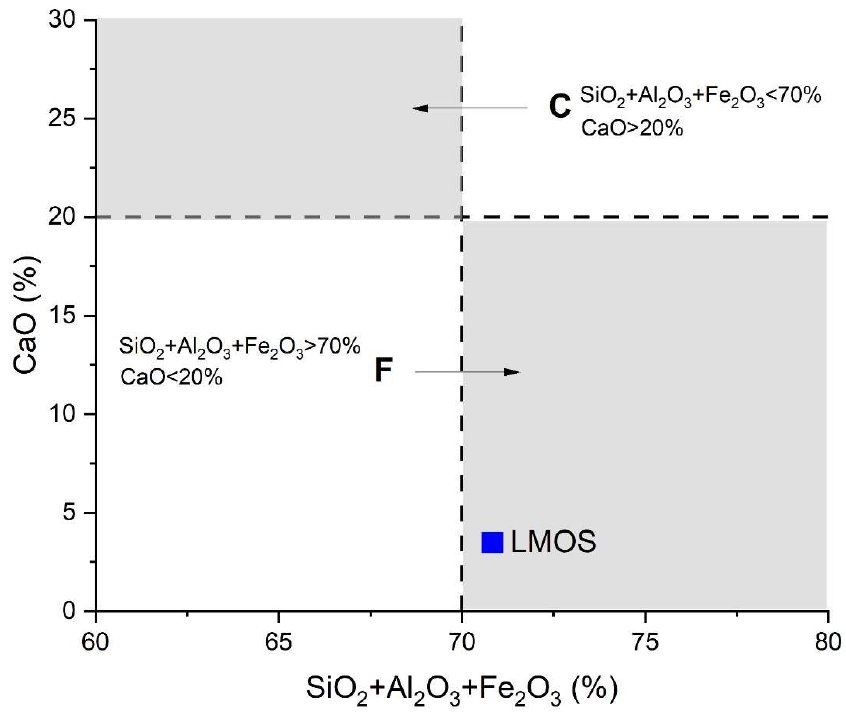
Figure 5. Positions of the tested sample LMOS in the ASTM ash fly